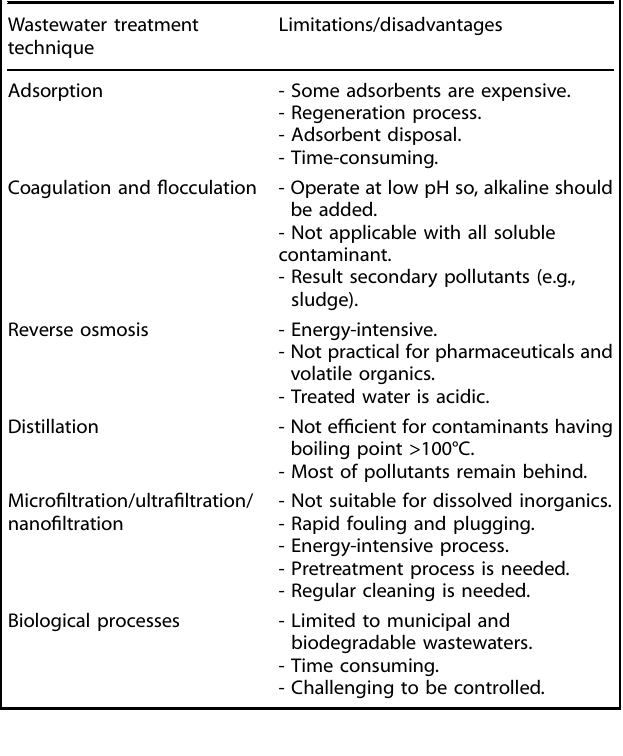
Table 1. Limitations and drawbacks of different technologies used in wastewater treatment.